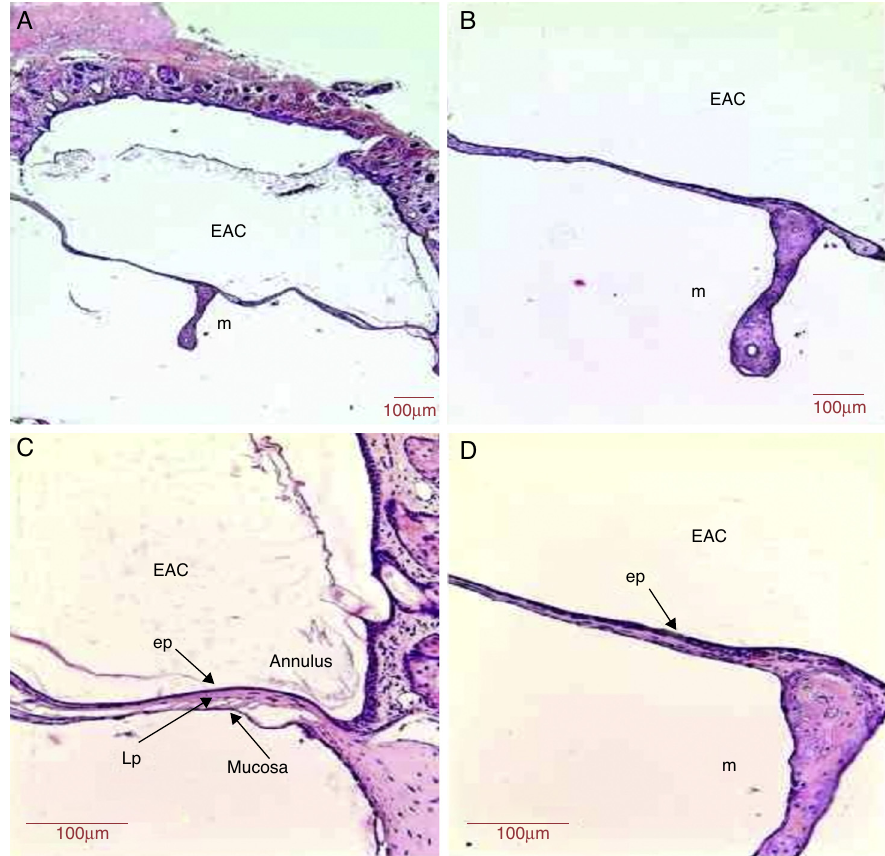
Histological section images of rat TM 10 days after traumatic perforation, stained with HE. EAC, external auditory canal; m, malleus handle; ep, epithelial layer; Lp, lamina propria; annulus, tympanic annulus; mucosa, mucosal layer. Image (A) shows a magnification of 40 × ; (B) 100 × and (C and D) 200 ×